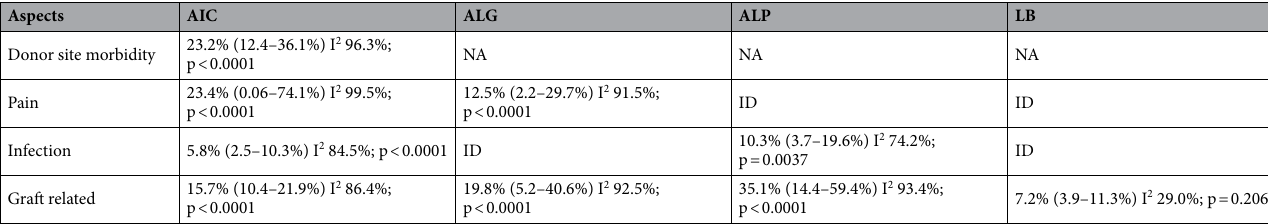
Table 4. Adverse events proportions analysis. AIC Autologous iliac crest, ALG allograft, ALP alloplastic, LB local bone, NA not applicable, ID insufficient data for